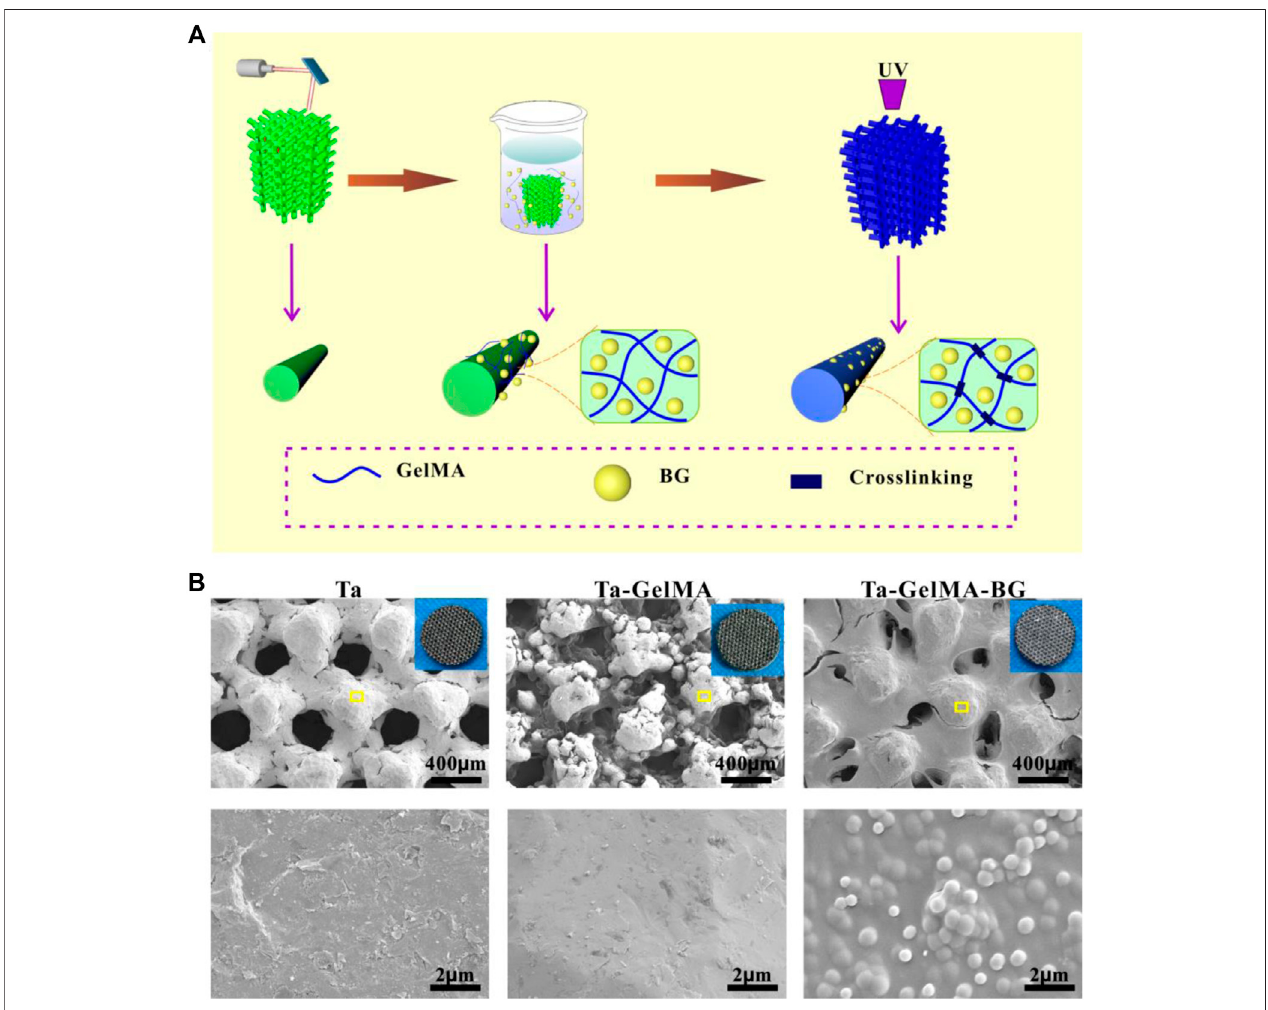
FIGURE 1 | Fabrication and observation of Ta – GelMA – BG scaffolds. (A) Schematic illustration of the fabrication process of Ta – GelMA – BG scaffolds. (B) SEM analysis of the surface structure of Ta, Ta – GelMA, and Ta – GelMA – BG scaffolds. The inserted image of B shows digital photos of the scaffolds and the yellow box indicates the enlarged